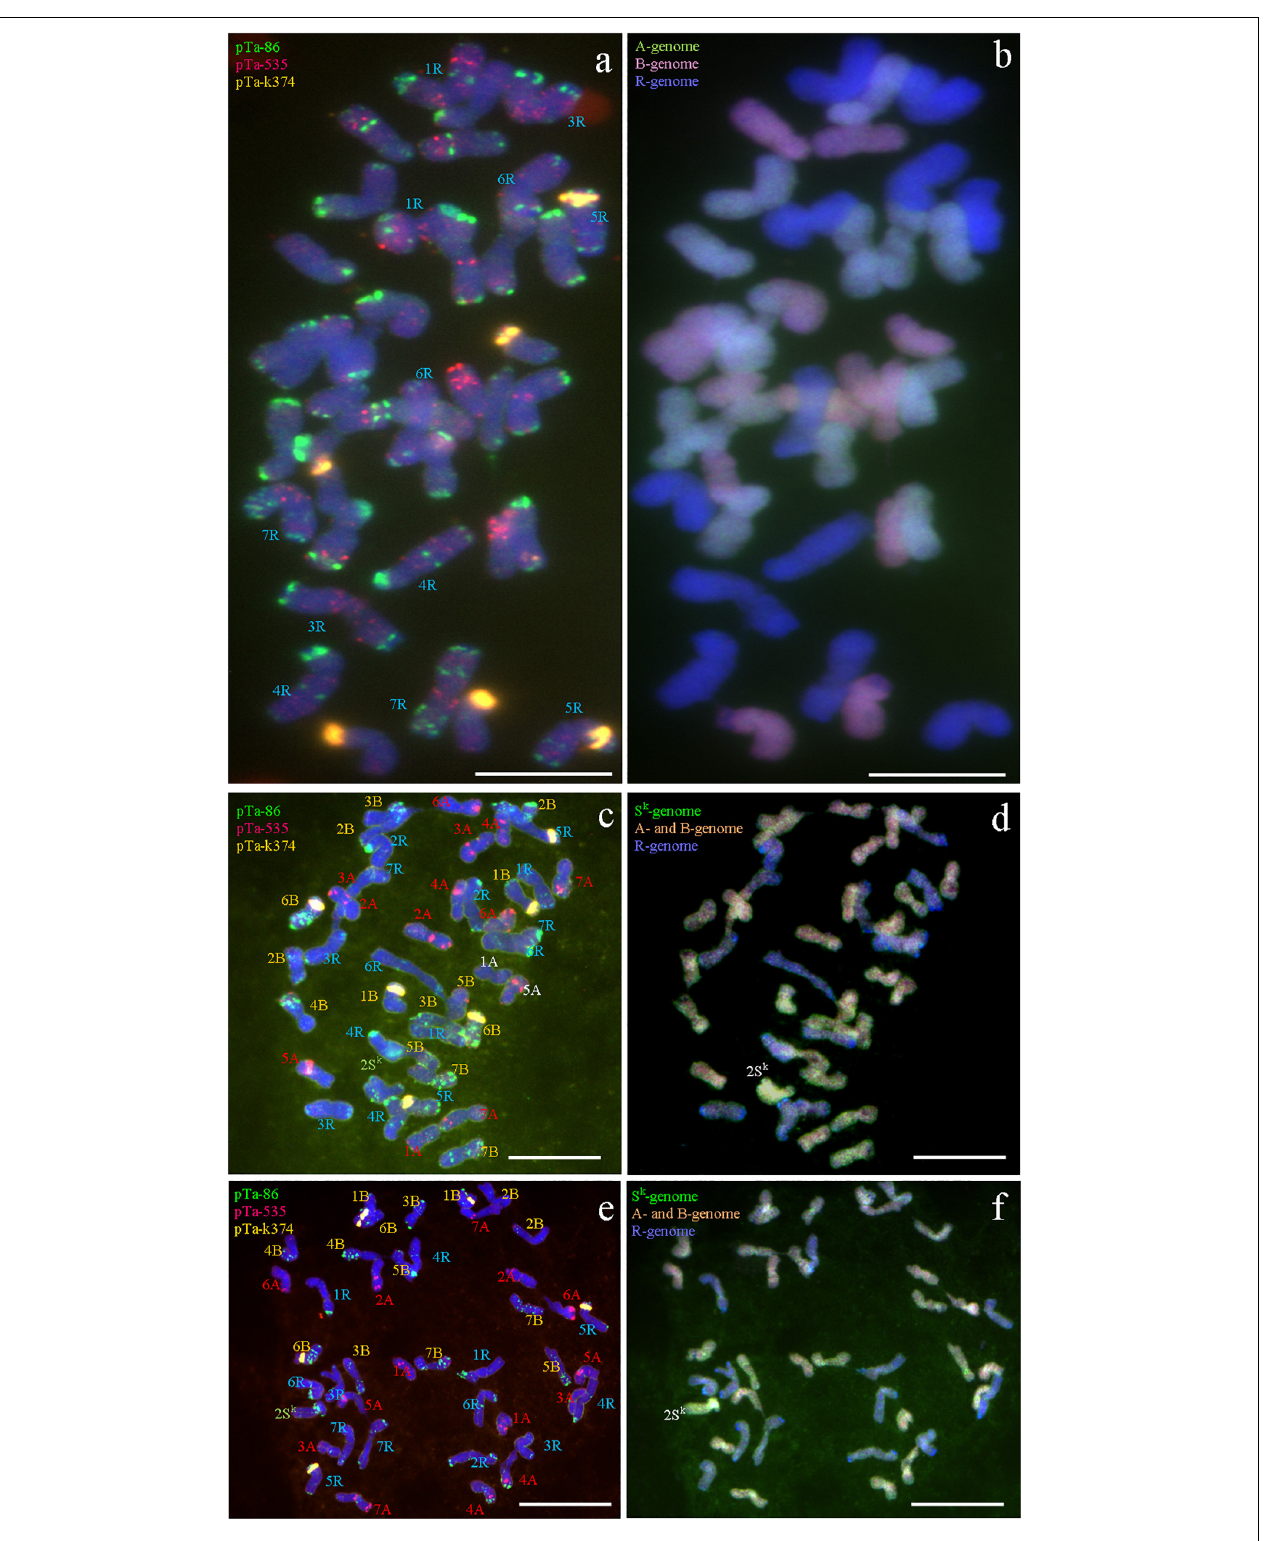
FIGURE 7 | Fluorescence and genomic in situ hybridization performed on mitotic chromosomes of: (a,b) nullisomic 2R plant of triticale (2 n = 40); (c,d) monosomic 2S k addition plant of triticale (2 n = 43); (e,f) monosomic 2S k (2R) substitution plant of triticale (2 n = 42). pTa-86 (Atto-488; green), pTa-535 (Atto-550; red), and pTa-k374 (Atto-647; yellow) probes were used for FISH. Genomic probes of A-, B-, R-, and S k -genome were used for GISH. Scale bar, 10 µ m.